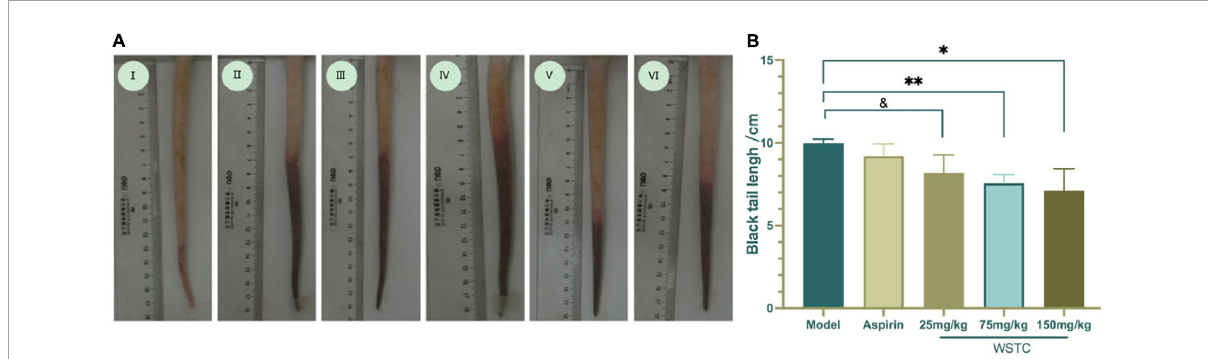
FIGURE4 Effects of water-soluble tomato concentrate (WSTC) on rat tail thrombosis in the κ carrageenan-induced black tail model. (A) Representative images showing the tails of rats in the control group (I); κ -carrageenan-induced black tails in the model group (II); Aspirin group (III); WSTC 25 mg · kg − 1 group (IV); WSTC 75 mg · kg − 1 group (V), and WSTC 150 mg · kg − 1 group (VI). (B) Mean length of black coloration in the tails of rats in the Model group; Aspirin group; WSTC 25 mg · kg − 1 group, WSTC 75 mg · kg − 1 group, and WSTC 150 mg · kg − 1 group. & P < 0.10 compared to model group. ∗ P < 0.05, compared to model group; ∗∗ P < 0.01, compared to model group.